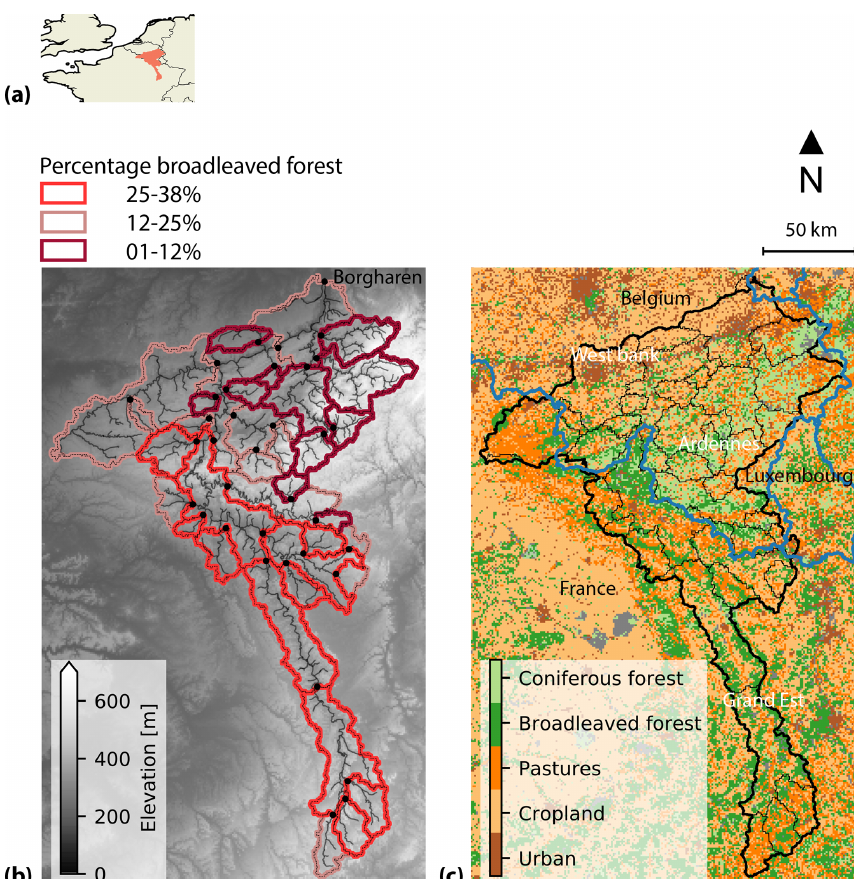
Figure 1. (a) Location of the Meuse basin in northwestern Europe. (b) Elevation in the basin and categorization of catchments according to their areal percentage of broadleaved forest. Black dots indicate the locations where streamflow observations are available. (c) The main land use types, according to CORINE Land Cover (European Environment Agency, 2018). The three main zones are the French southern part of the basin in the Grand Est region, the Ardennes and the area on the western bank of the